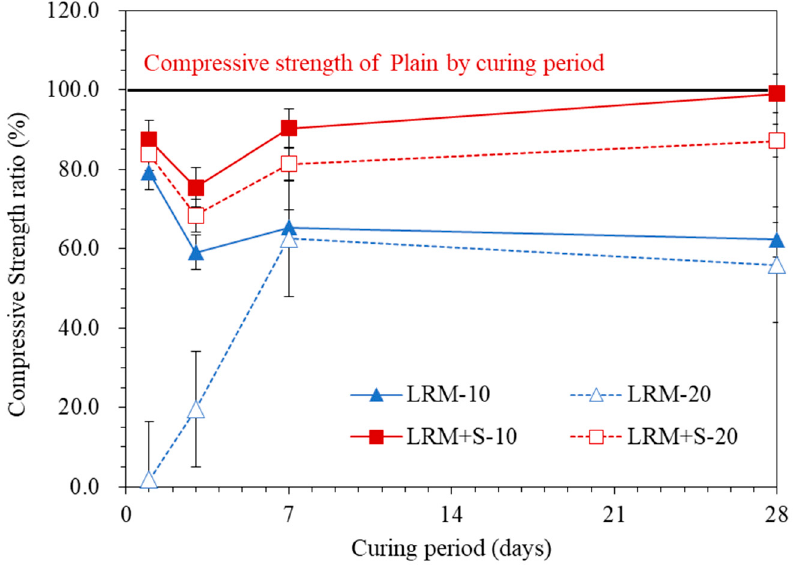
Figure 6. E ff ects of LRM and LRM + S on the compressive strength ratio of the cement Figure 6. Effects of LRM and LRM + S on the compressive strength ratio of the cement paste.